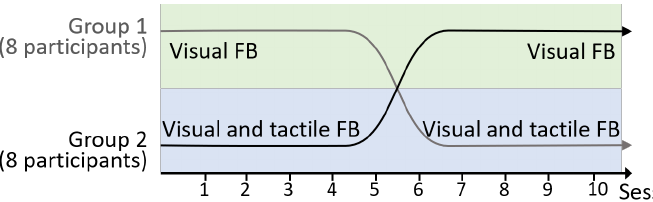
Figure 1. Type of feedback (FB) provided during the sessions depending on the